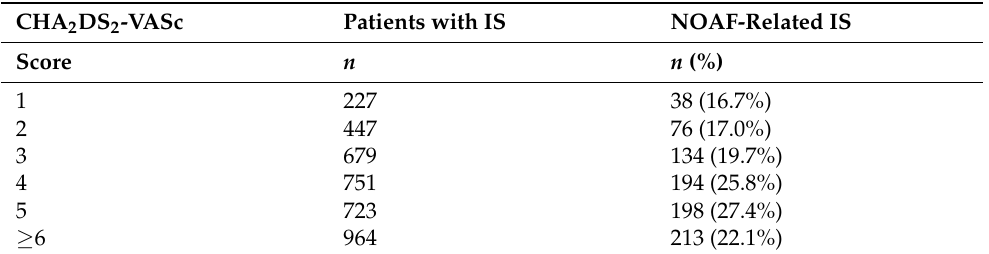
Table 3. Proportion of new-onset atrial fibrillation (NOAF)-associated ischemic strokes (IS) during a 10-year follow-up of myocardial infarction patients without baseline AF. CHA 2 DS 2 -VASc Patients with IS